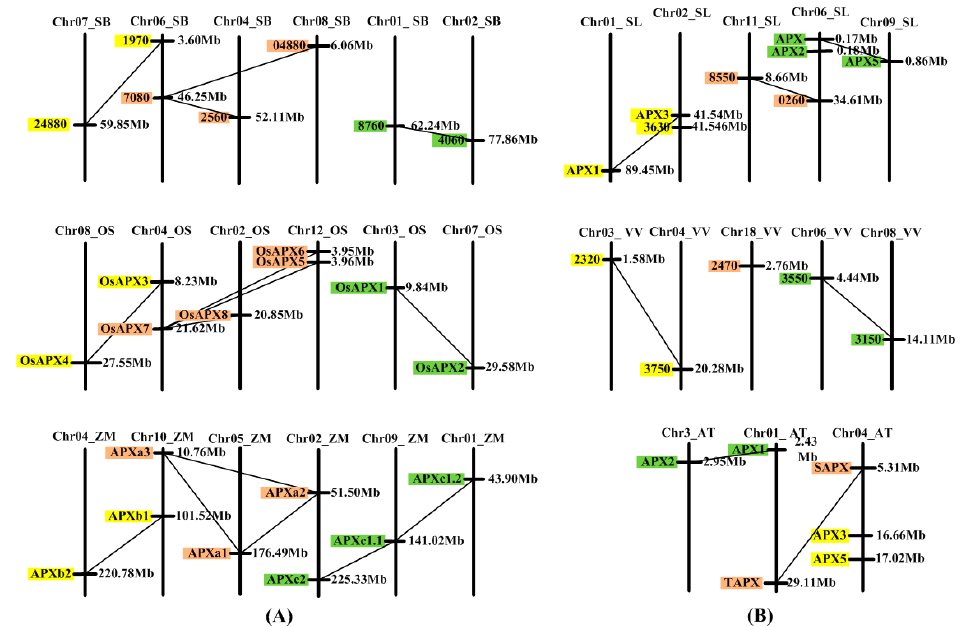
Figure 4. Chromosome localization of APX gene and whole-genome duplication (WGD) events in monocotyledon and dicotyledon. ( A ) Chromosome localization of APX genes and WGD events in monocotyledon. ( B ) Chromosome localization of APX genes and WGD events in dicotyledon. The long black bars represent chromosomes. The chromosome number and species are marked above the long black bar. For example, Chr07_SB represents chromosome 7 of sorghum. The right side of the long black bar marks the position of the gene in the chromosome, and the left side of the long black bar marks the name of the gene. The black lines between genes indicate that the genes were produced by WGD. Orange, yellow, and green indicate the genes of classes A, B, and C, respectively. ZM, Zea mays